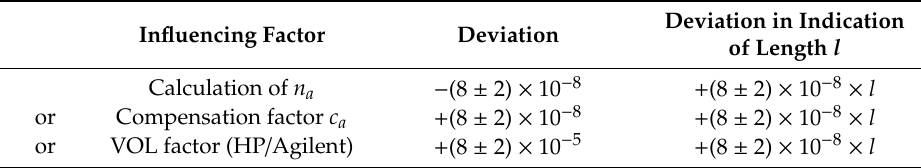
Table 4. Several alternatives to report the result of a software